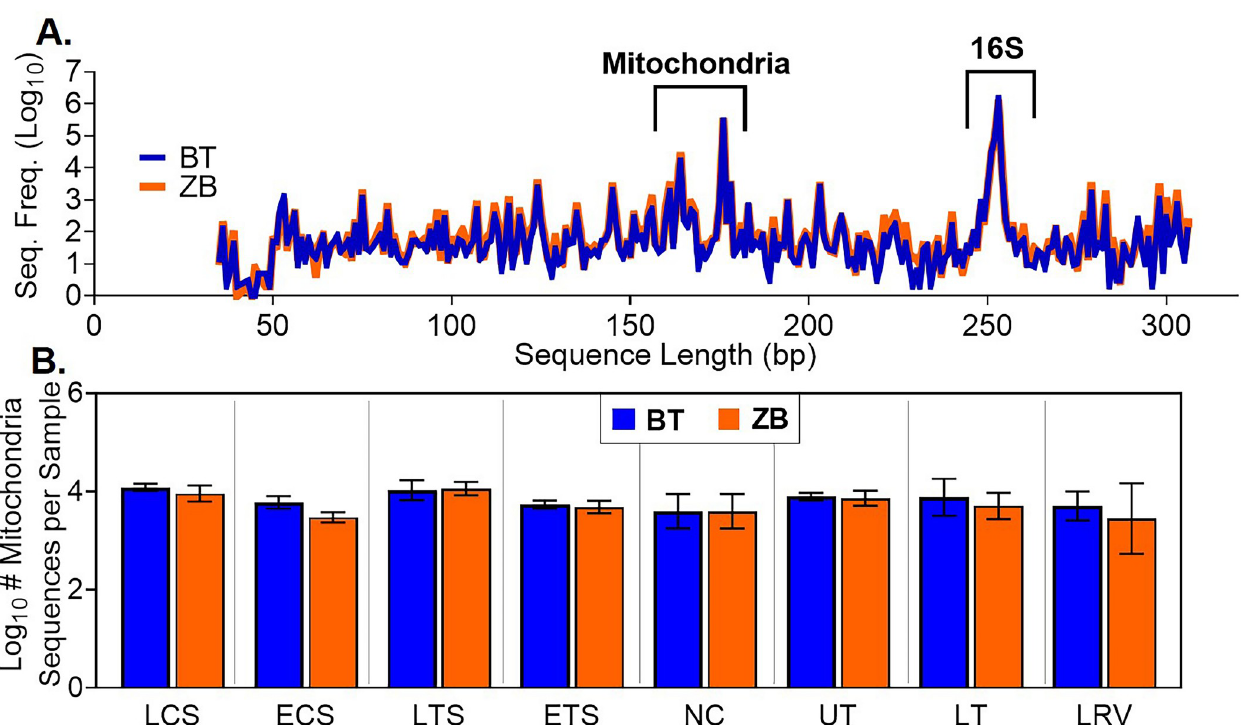
Fig 4. Host sequences detected in Illumina sequencing data. (A) Sequence length distribution showing the size ranges for avian mitochondria (175, 176, 178, and 194 bp) and 16S rRNA gene sequences (250–264 bp). (B) Statistical comparisons of mitochondria gene sequences in different tissue types. Statistical differences, � p < 0.05 (pairwise Kruskal-Wallis tests, with a Benjamini-Hochberg correction for false discovery).